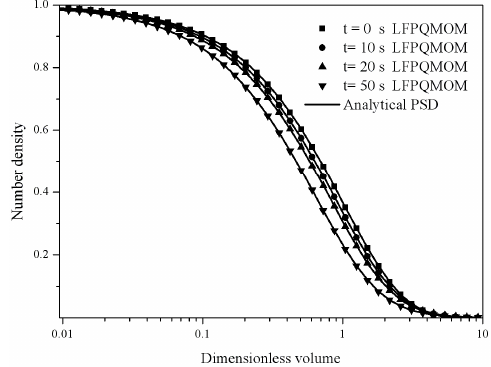
Figure 10. Particle size distribution at 0, 10, 20, and 50 s for the pure aggregation process with product kernel and exponential initial PSD (Square: numerical PSD at 0 s; circle: numerical PSD at 10 s; up triangle: numerical PSD at 20 s; down triangle: numerical PSD at 50 s; line: analytical PSD).